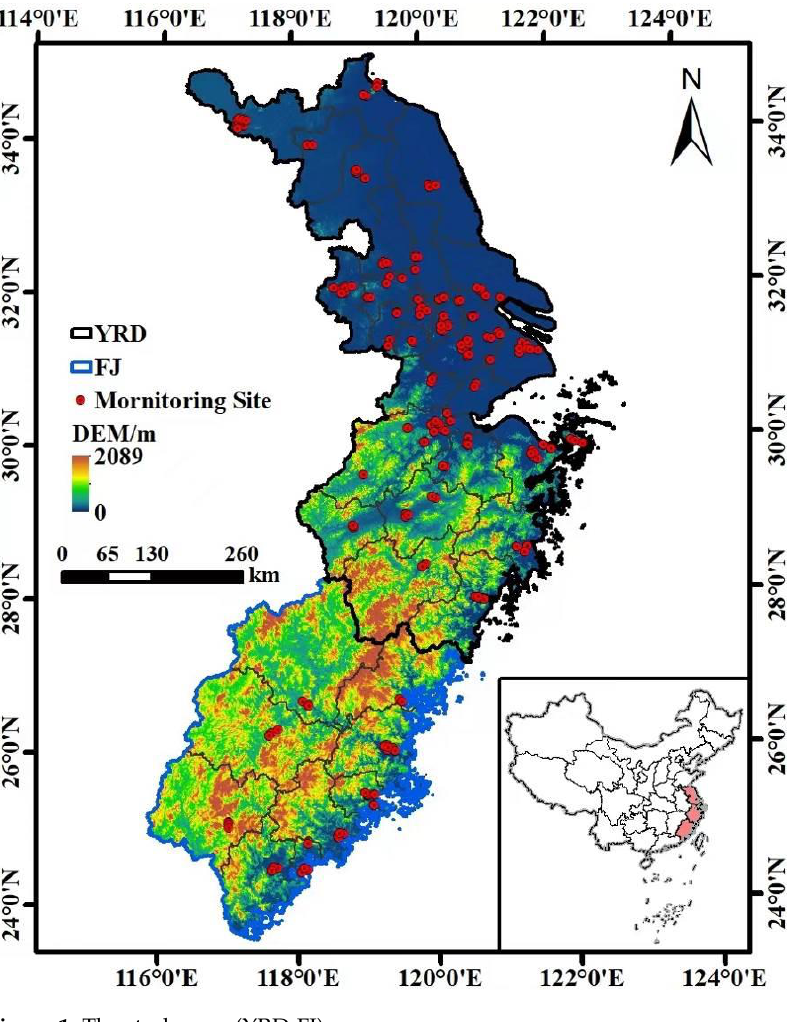
Figure 1. The study area